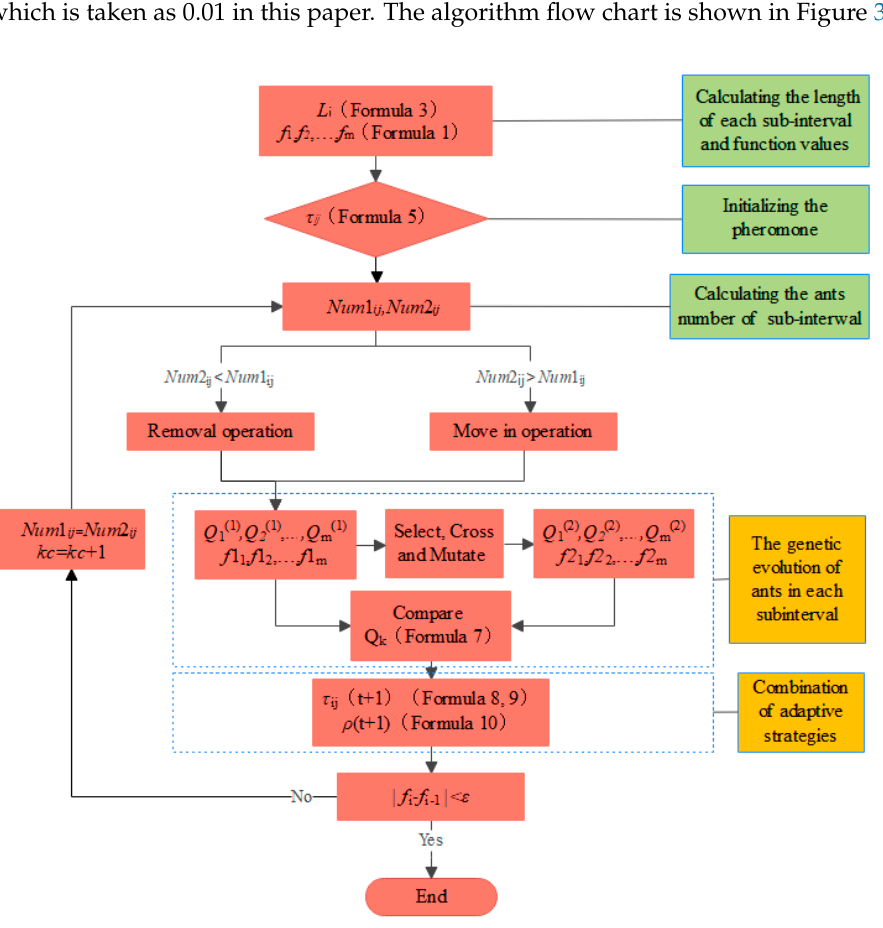
Figure 3. Algorithm flow chart.